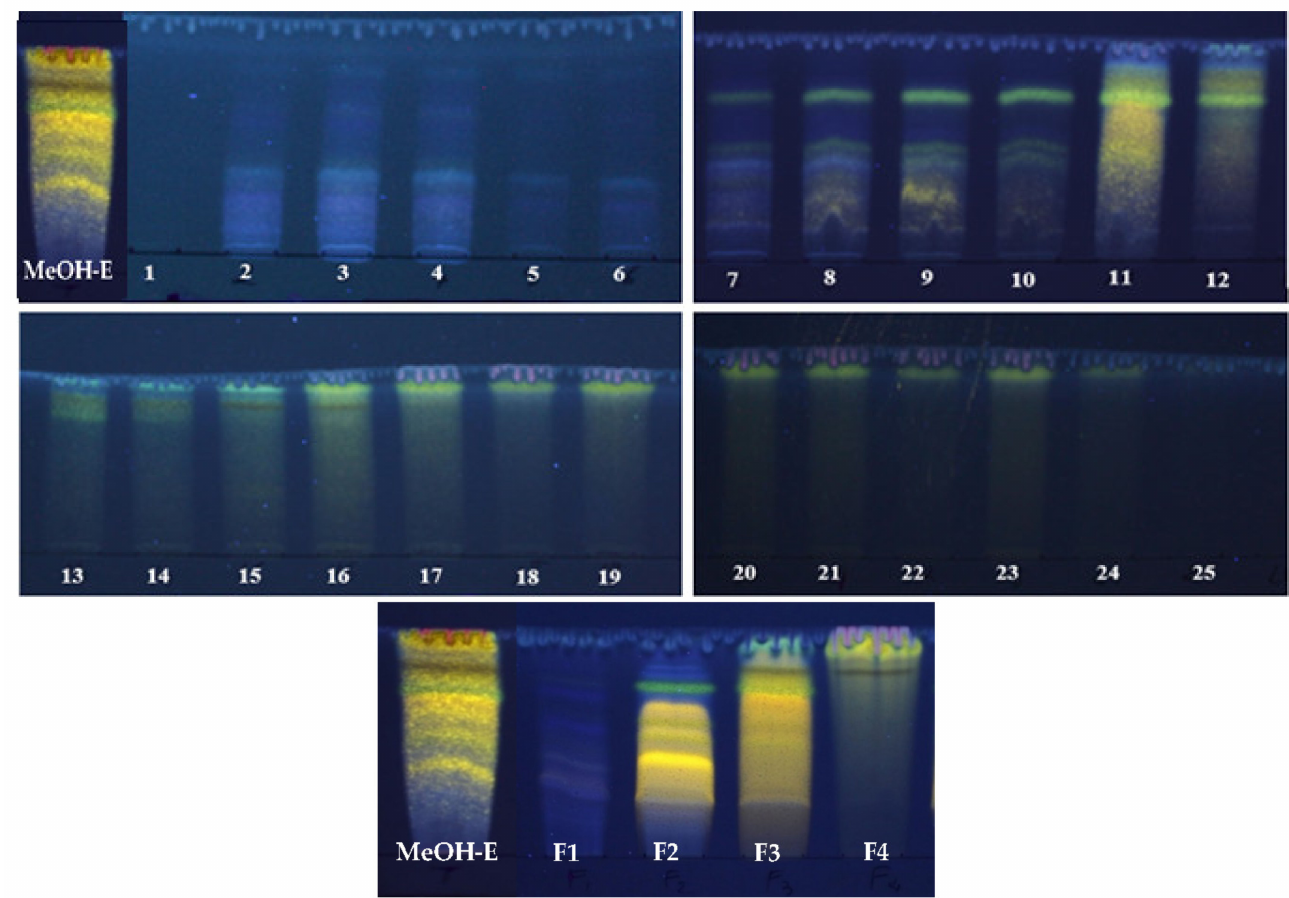
Figure 1. Thin-layer chromatography (revealed by natural products/polyethylenglycol reagent) of the R. raetam methanolic extract (MeOH-E), of the 25 fractions obtained by its column fractionation and of the fractions F1–F4 (originated after the combination of distinct chromatographic